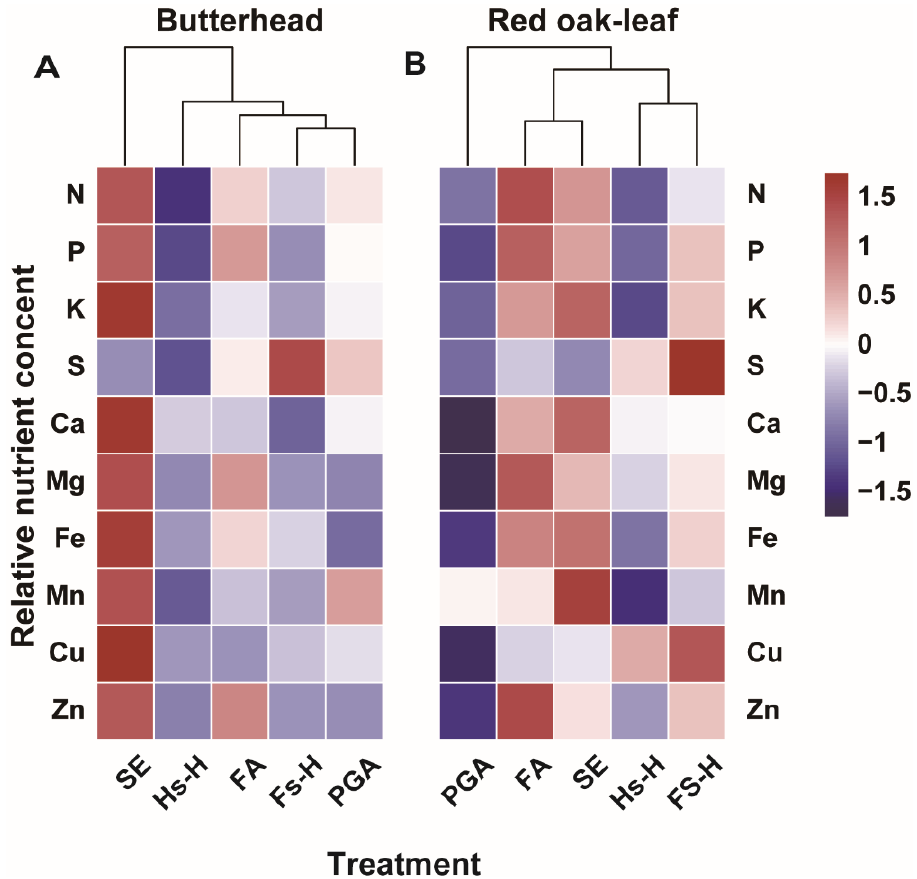
Figure 3. Macro and micronutrient concentration in the shoots of ( A ) butterhead and ( B ) red oak- leaf under different nutrient solution treatments. Nutrient concentration was normalized by the z−score; the red and blue colors indicate upregulation and downregulation, respectively.